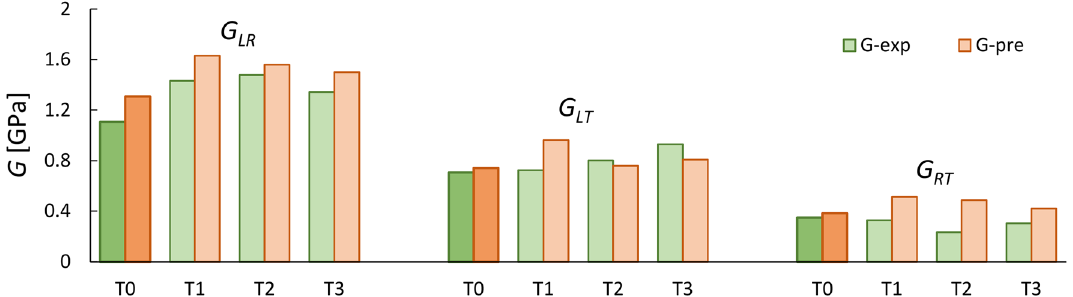
Figure 8. A comparison between experimental shear modulus (reported in Gòmez-Royuela et al. 20 ) with predicted values using the Saint-Venant model for untreated and modified beech.